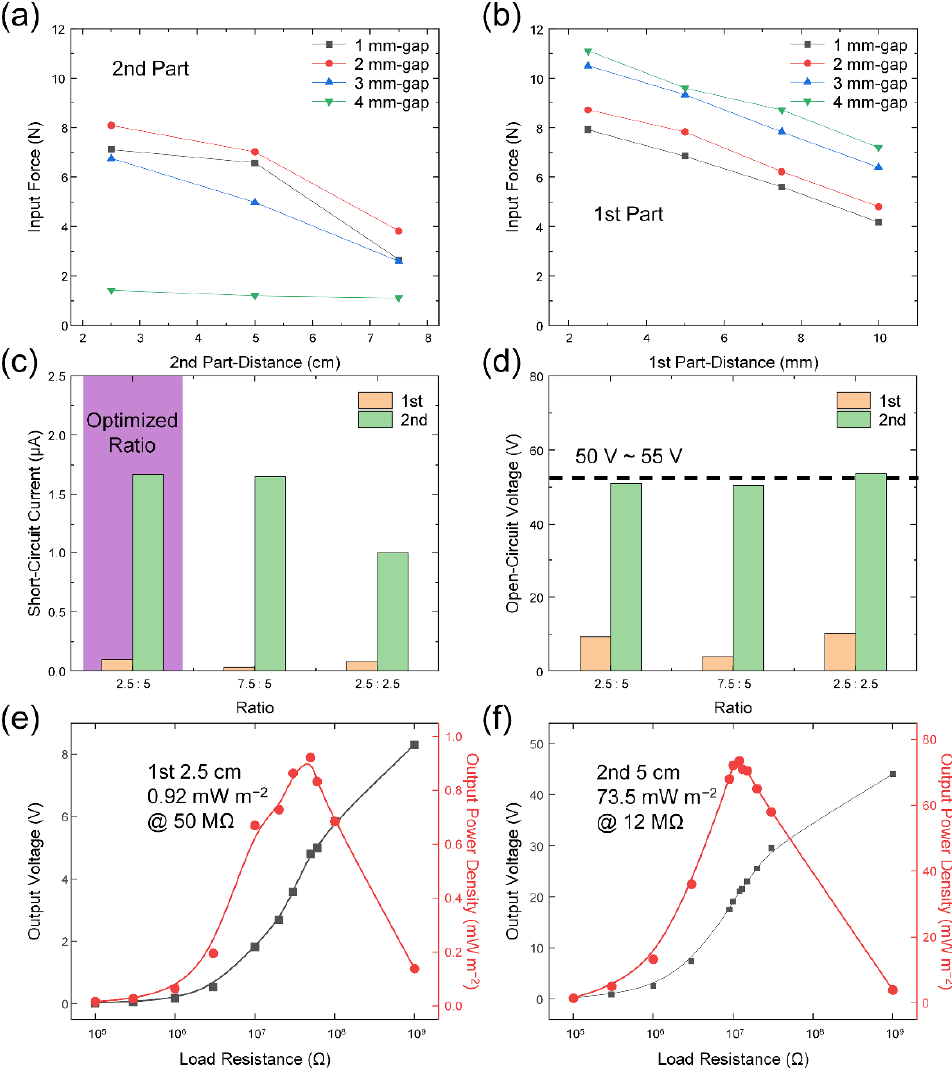
Figure 3. Input force and basic electrical characteristics of the fabricated L-TENG. Input force of the ( a ) 2nd part- and ( b ) 1st part-TENGs with different gap-distance between two layers of the 2nd part. ( c ) I SC and ( d ) V OC of the different distance ratio. Output power density with the ( e ) 1st part- and ( f ) 2nd part-TENGs.